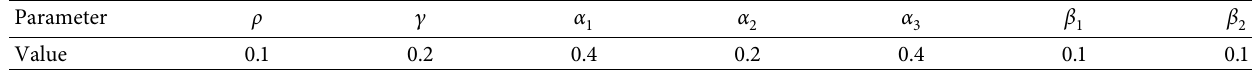
Table 2: Values of parameters based on